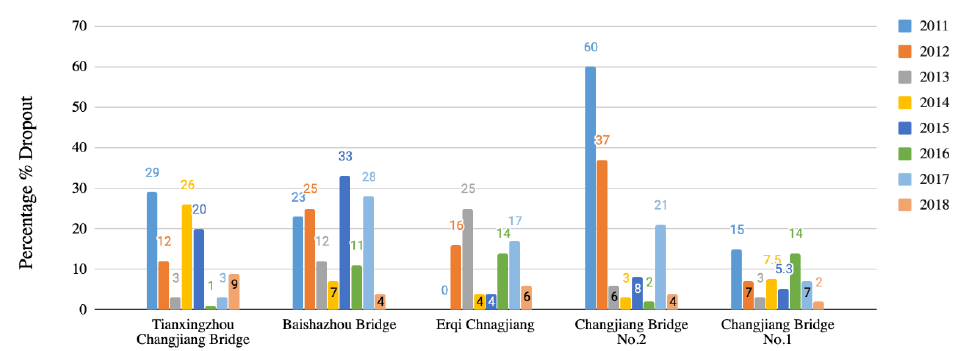
Figure 13. Average weekend traffic reduction rate (in %) from 2011 to 2018 for 5 bridges crossing the Yangtze river within the city of Wuhan, estimated based on the COSMO-SkyMed data analysis.